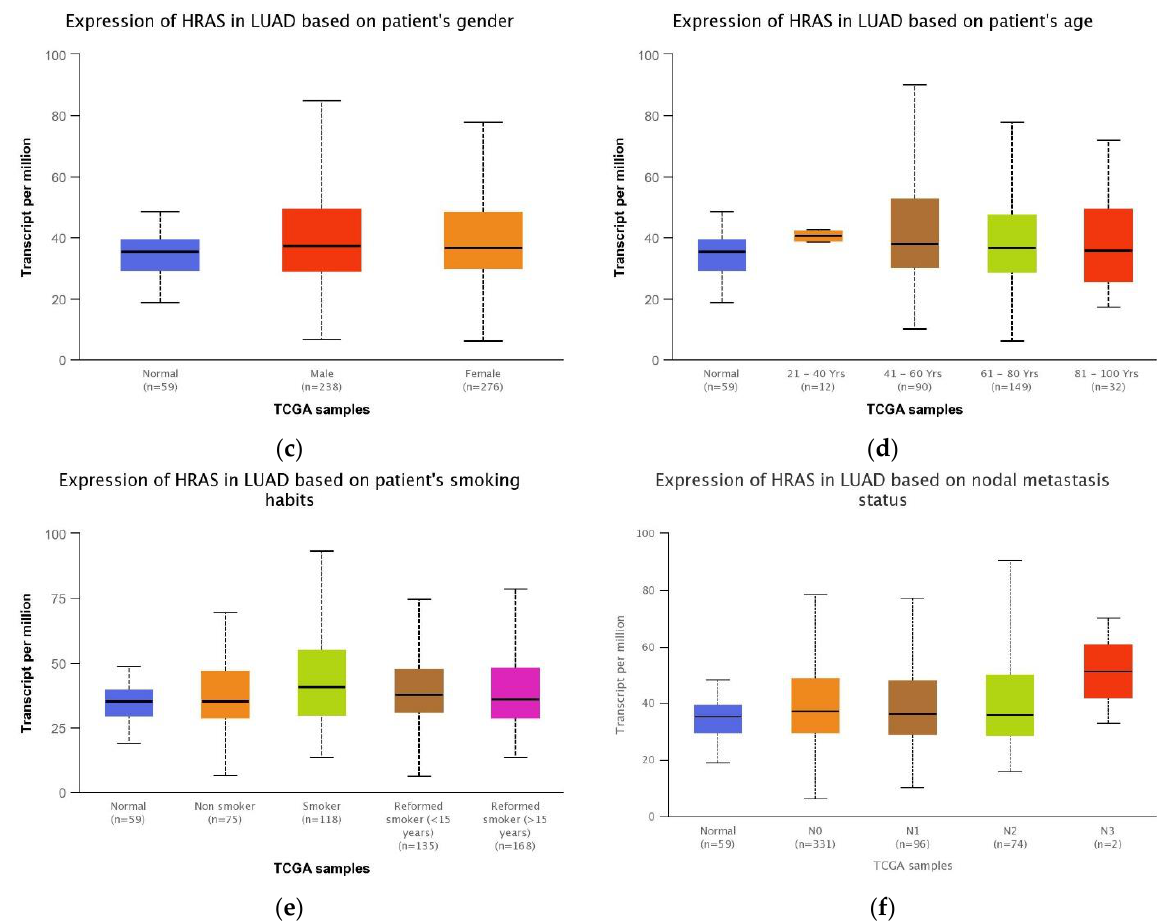
Figure 5. HRAS expression profile in lung adenocarcinoma. Box-whisker plots show the expression of KRAS in normal and tumor samples ( a ), tumor subgroups based on individual cancer stages ( b ), patient sex ( c ), age ( d ), smoking status ( e ), nodal metastasis ( f ) (Data derived from the UALCAN server (http://ualcan.path.uab.edu/ (accessed on 15 June 2022))).